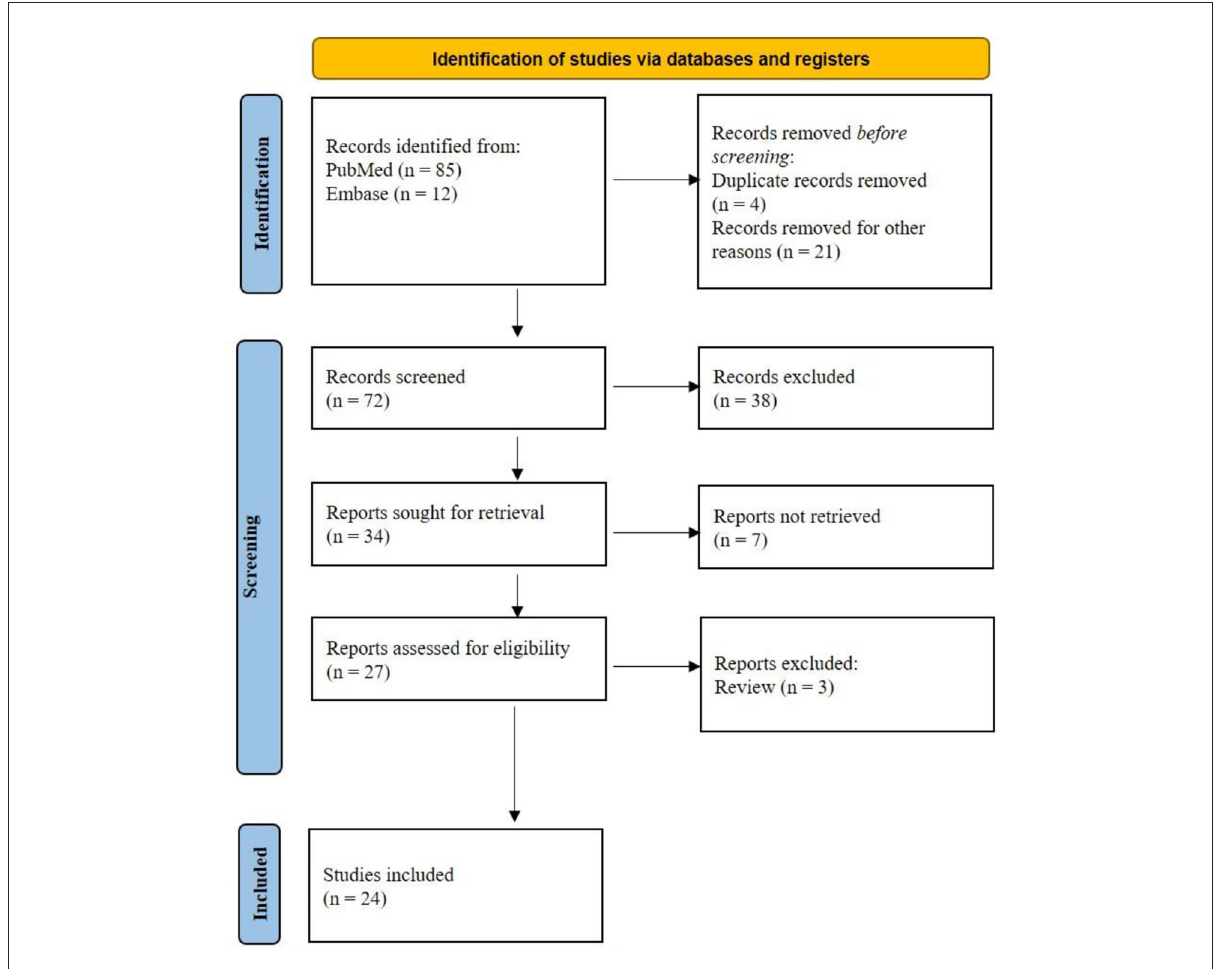
FIGURE1 PRISMA flow diagram of study